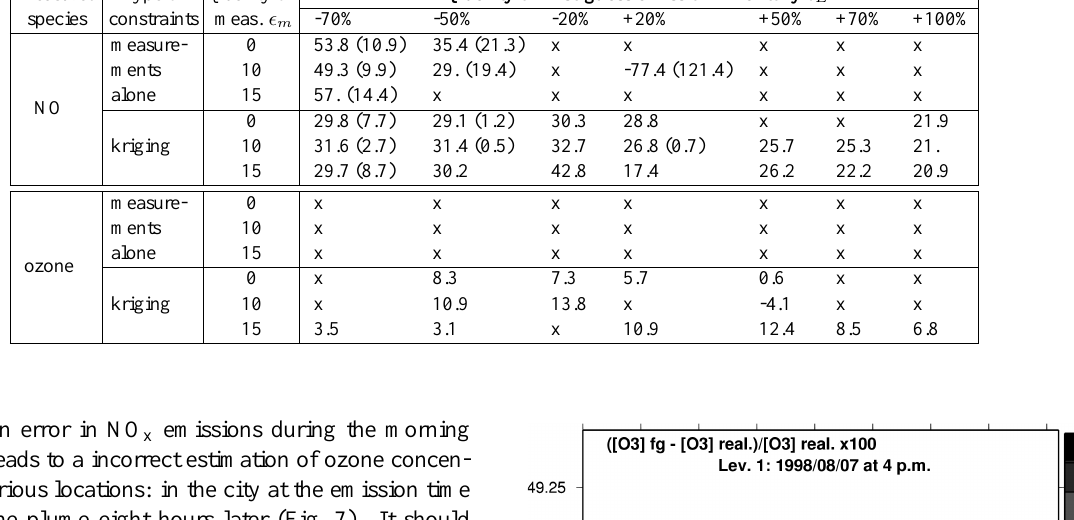
of Table 2, adding the B matrix leads to a slight homoge- nization of the space and time distribution of the corrections compared to the m-case. Finally, when using kriging, the corrections are homogeneously distributed and the first-guess difference of 50% with the true fluxes is reduced to an aver- age 34.3%.